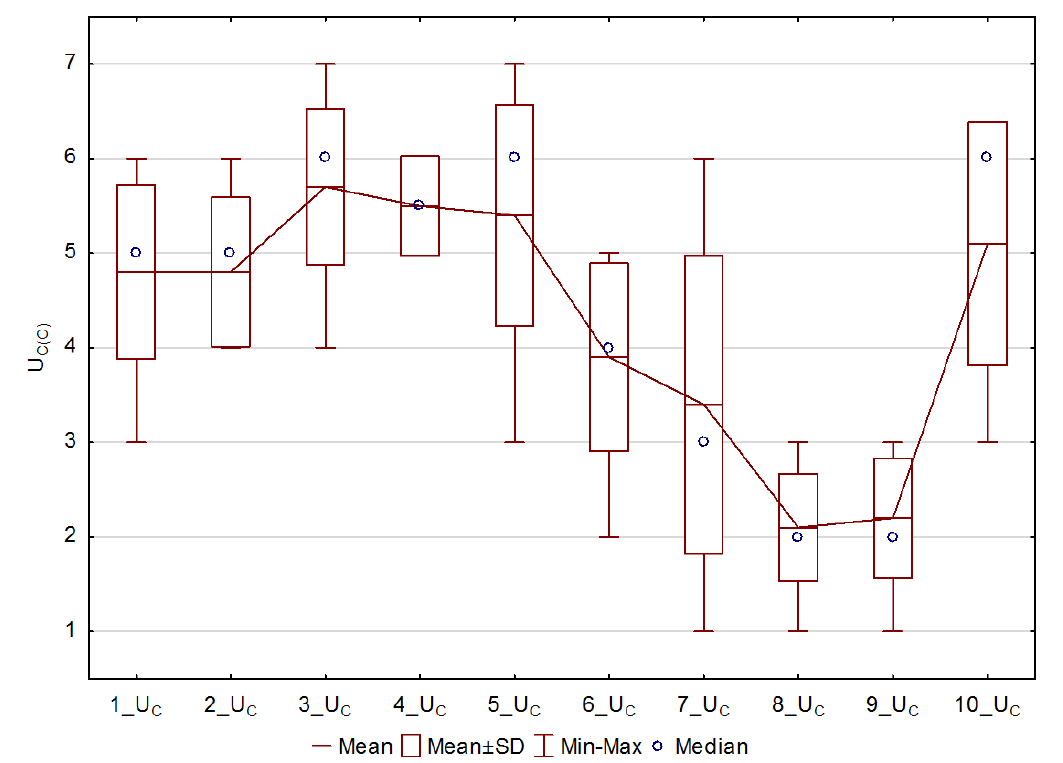
Figure 26. Ceiling uniformity perception for group C.